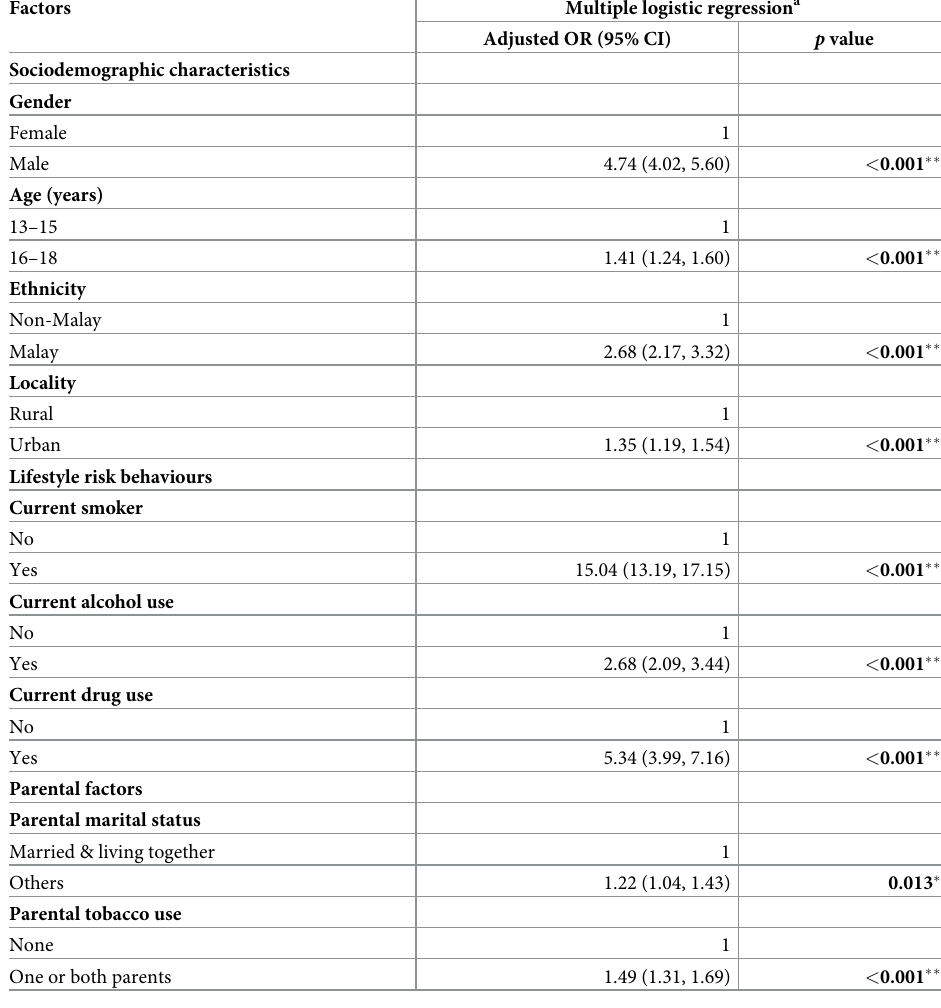
Table 3. Factors associated with current e-cigarette use among in-school adolescents in West